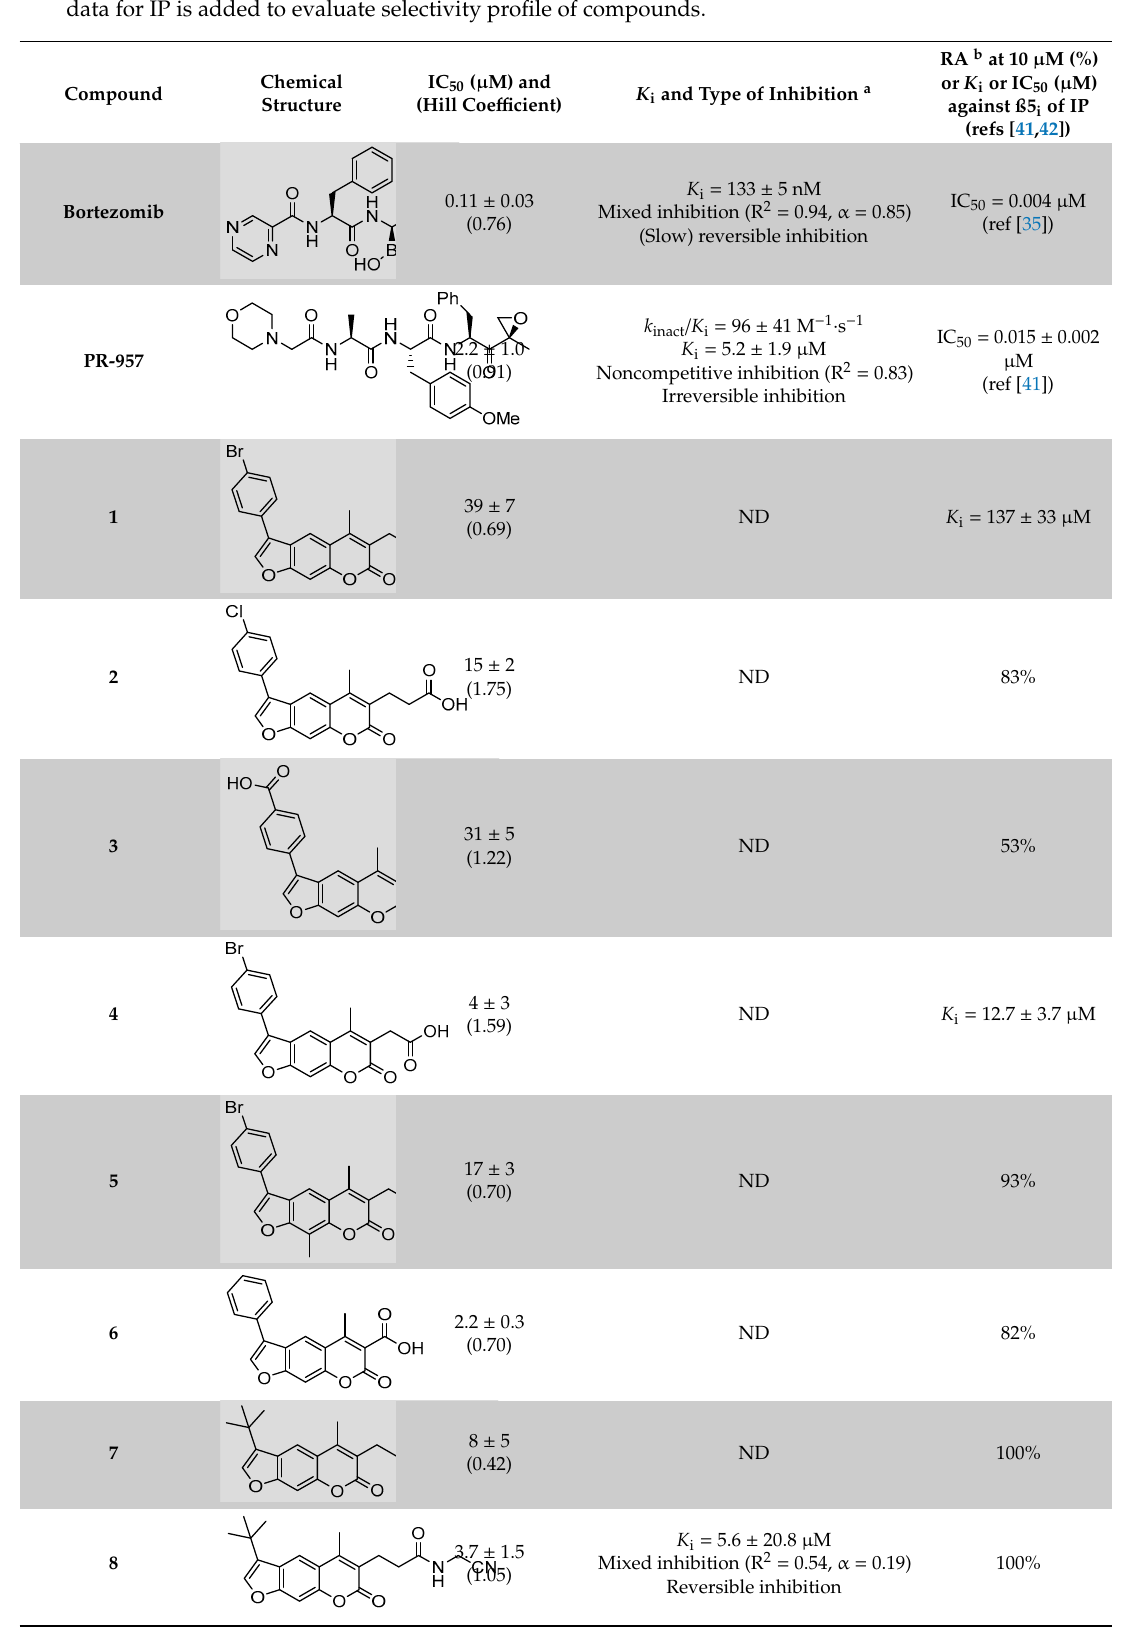
Table 1. The inhibitory potencies of selected psoralen derivatives against the Mtb proteasome. Inhibition data for IP is added to evaluate selectivity profile of